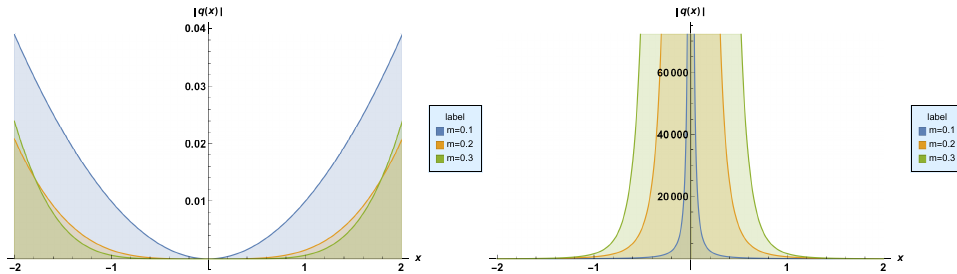
Figure 5. Profiles of stationary dark and singular solitons, respectively.